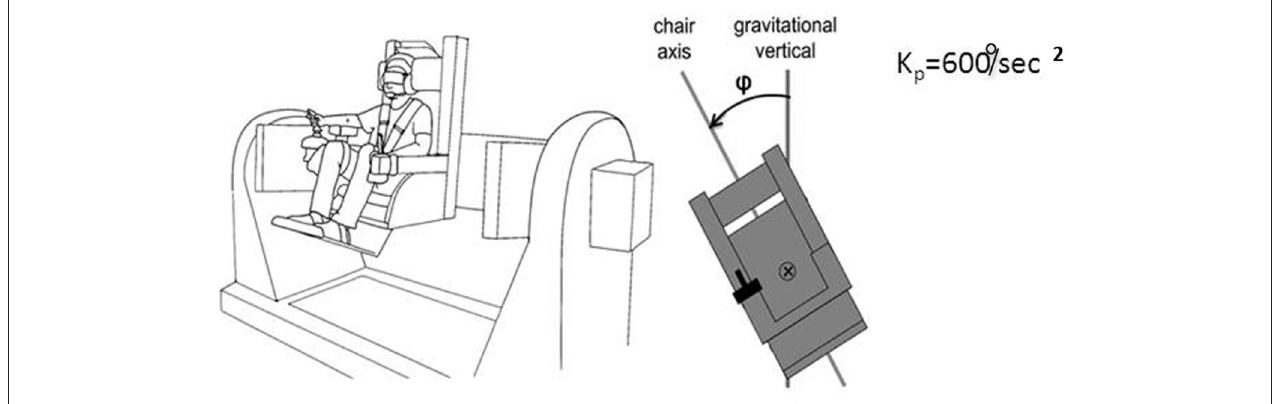
FIGURE 9 | Illustration of the MARS configured for vertical plane roll balancing. The axis of roll motion is indicated by the ⊗ symbol, the deviation from the gravitational vertical is angle ϕ . Kp = 600 ◦ /s 2 is the inverted pendulum constant.